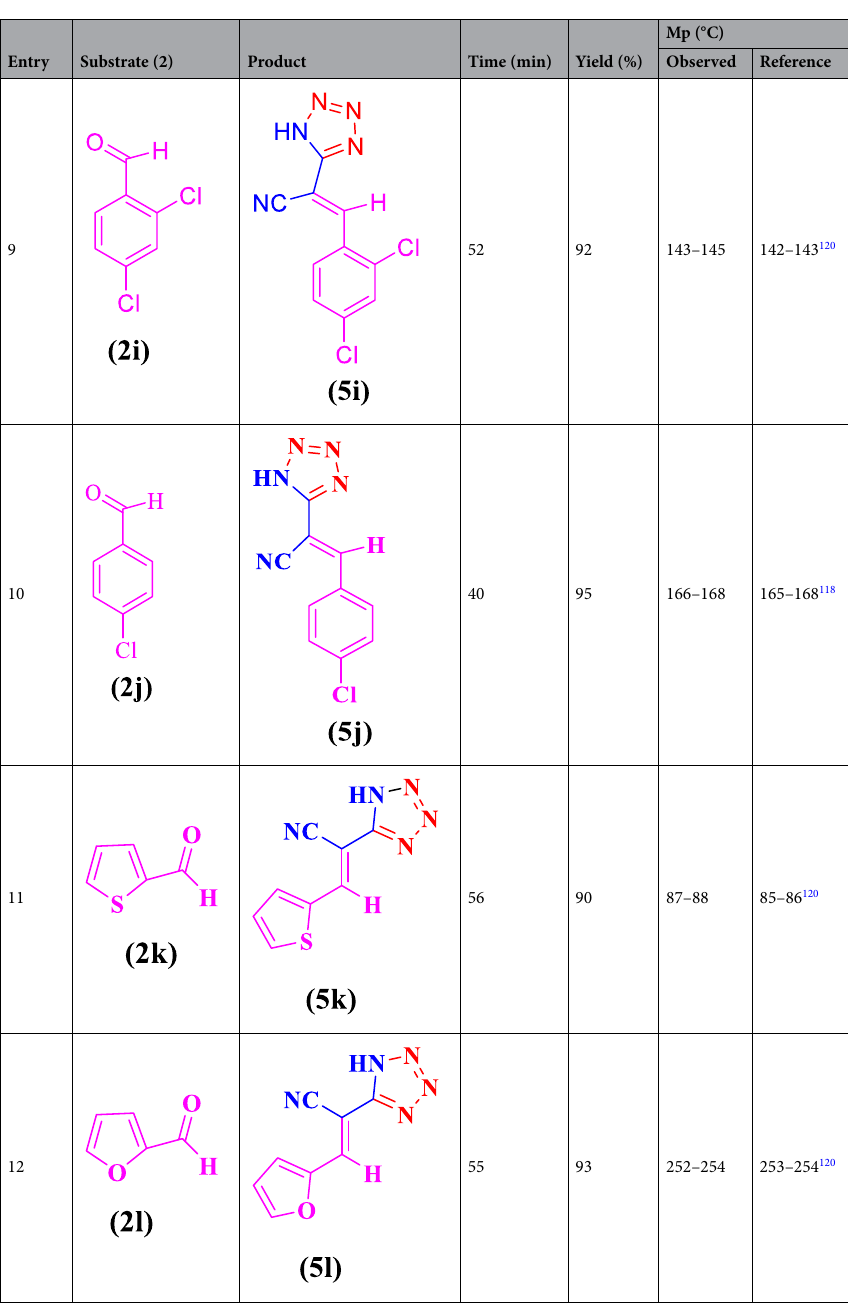
Table 3. Scope of the synthesis of different 2-(1 H -tetrazol-5-yl) acrylonitrile derivatives 5a–l catalysed by Cu@APS-TDU-PMO nanoreactor ( 1 ). Reaction conditions: aldehydes ( 2 , 1 mmol), malononitrile ( 3 , 1